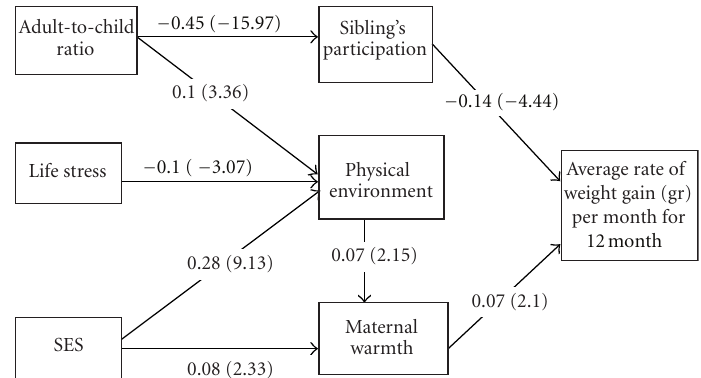
Figure 1: Standardized path coe ffi cients ( t -values) for a path model between SES and infant weight gain, mediated by home environment in 1-year-old Chilean infants (CFI = 0.97, SRMR = 0.02, RMSEA = 0.03). All paths are statistically significant ( P < 0 . 05). SES significantly correlated with adult-to-child ratio and life stress. Model adjusted for direct relationship between number of children and average weight gain ( P < 0 . 05).